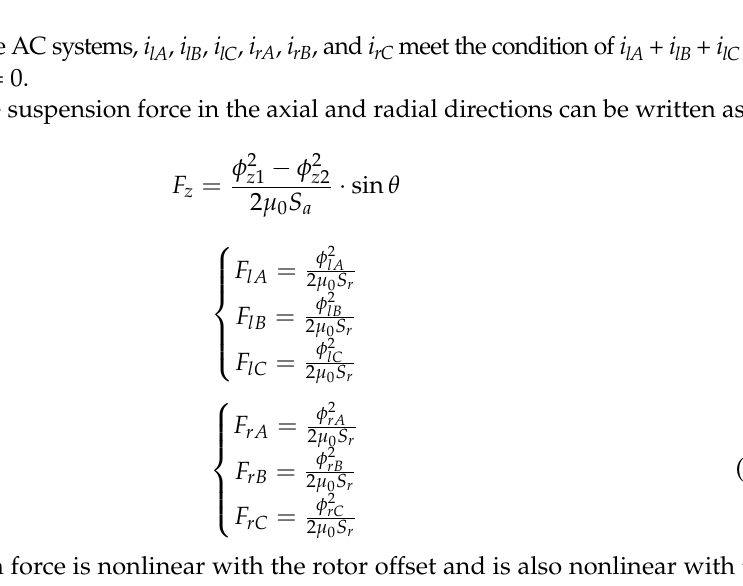
Figure 4. Equivalent control magnetic circuit: ( a ) left radial control fluxes, ( b ) right radial control fluxes, and ( c ) axial control fluxes.